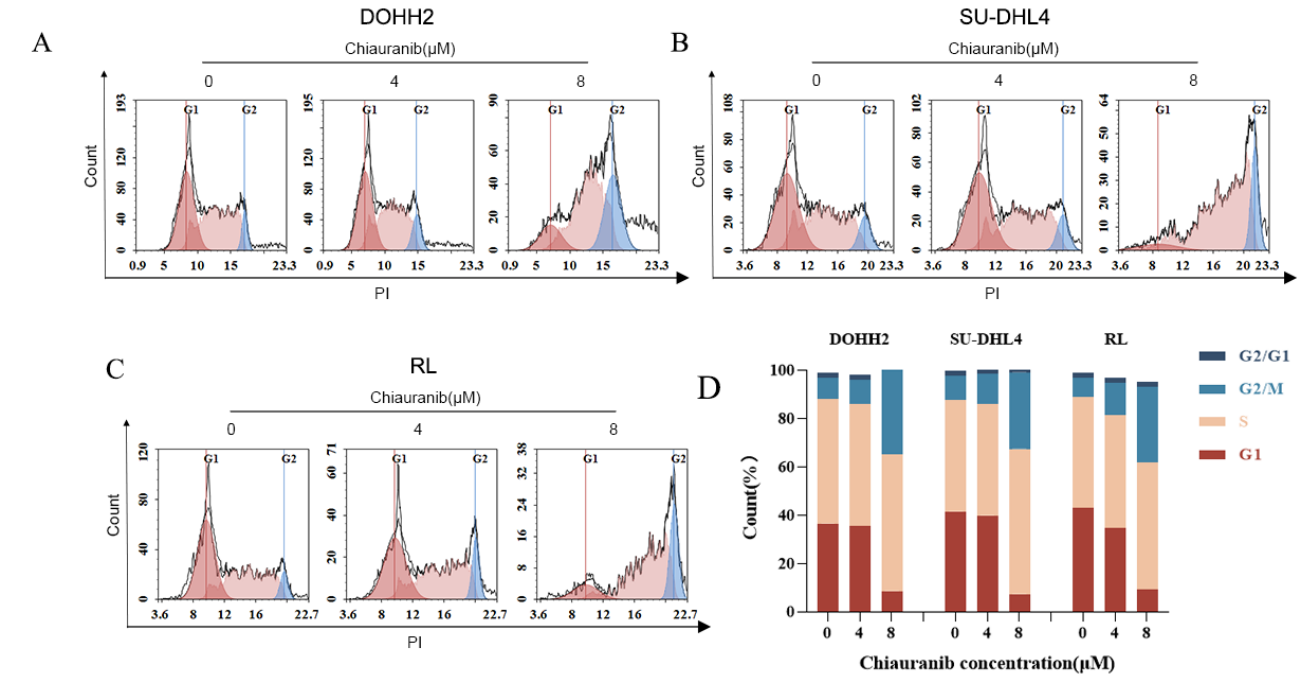
Figure 3. Chiauranib induces cell cycle arrest in the G2/M phase. The cell cycle of ( A ) DOHH2, ( B ) SU-DHL4, and ( C ) RL cells was arrested in the G2/M phase after treatment with chiauranib. ( D ) The corresponding cell cycle histograms were calculated.